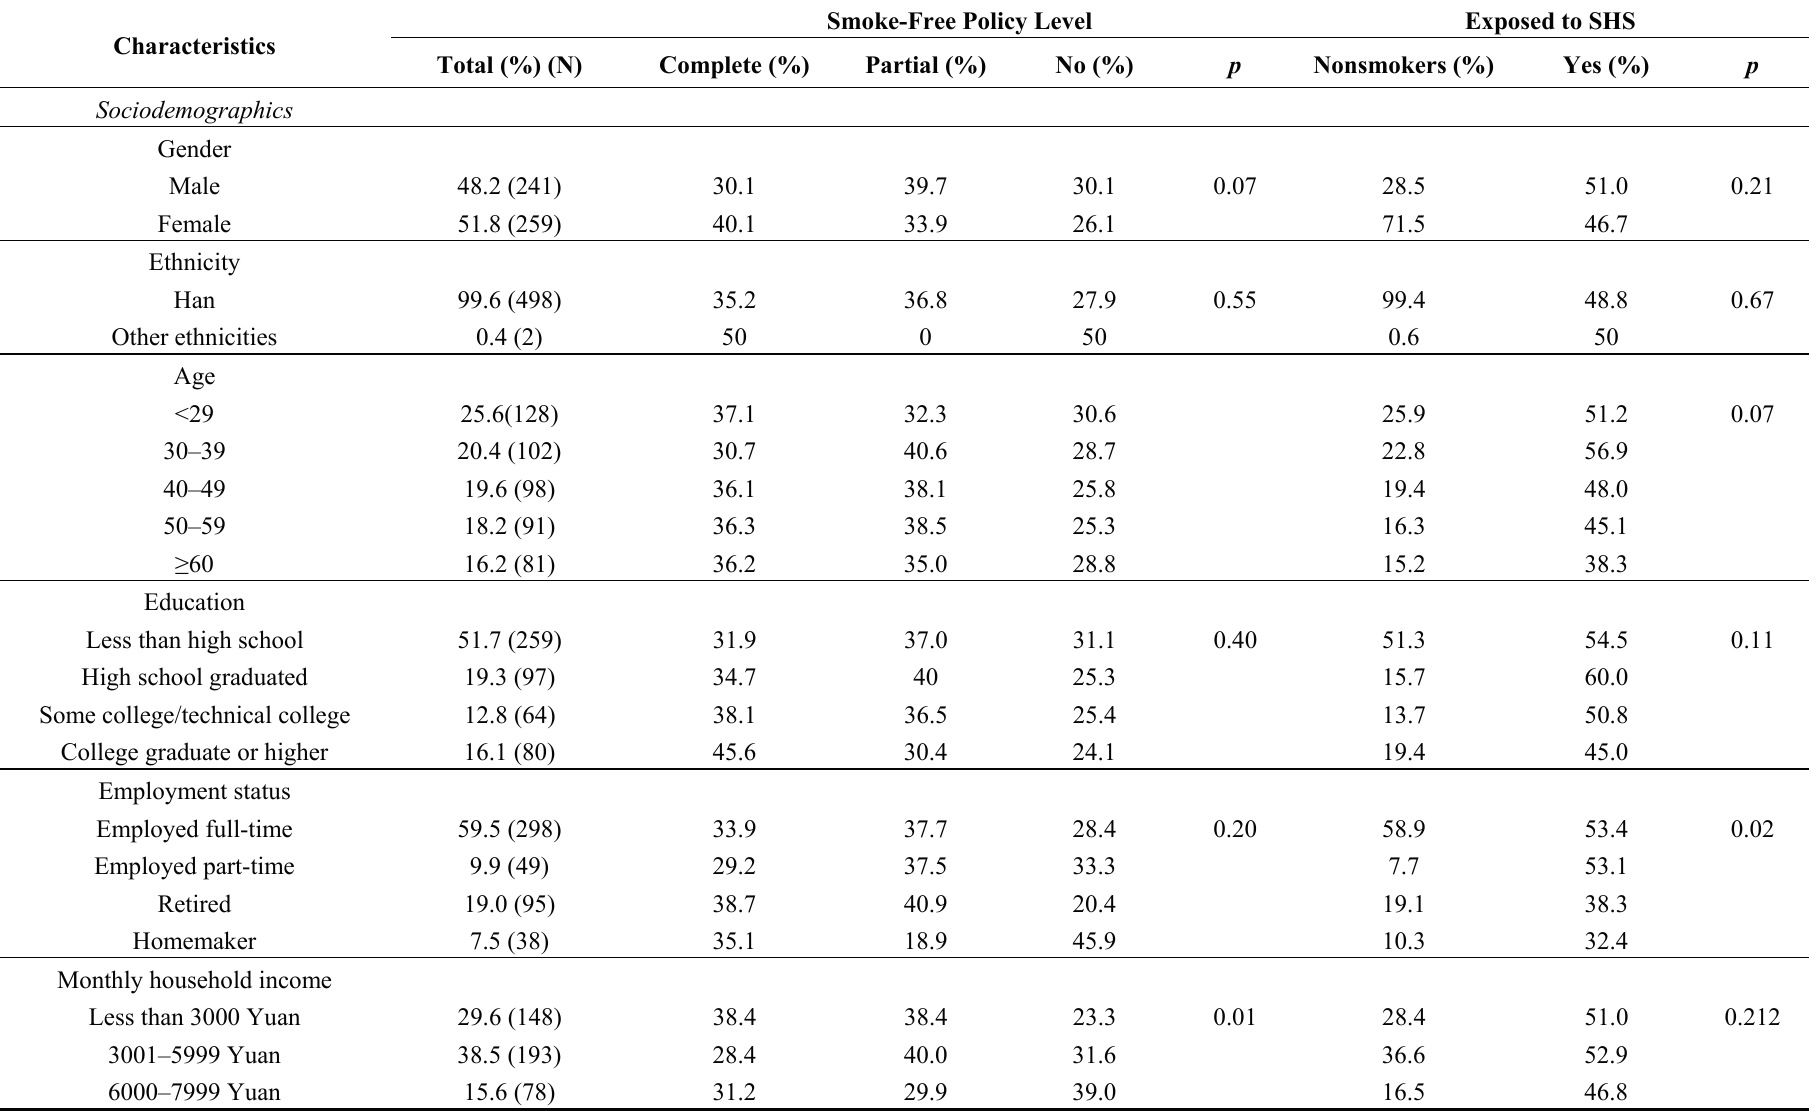
Table 1. Distribution of smoke-free home policy level and SHS exposure among